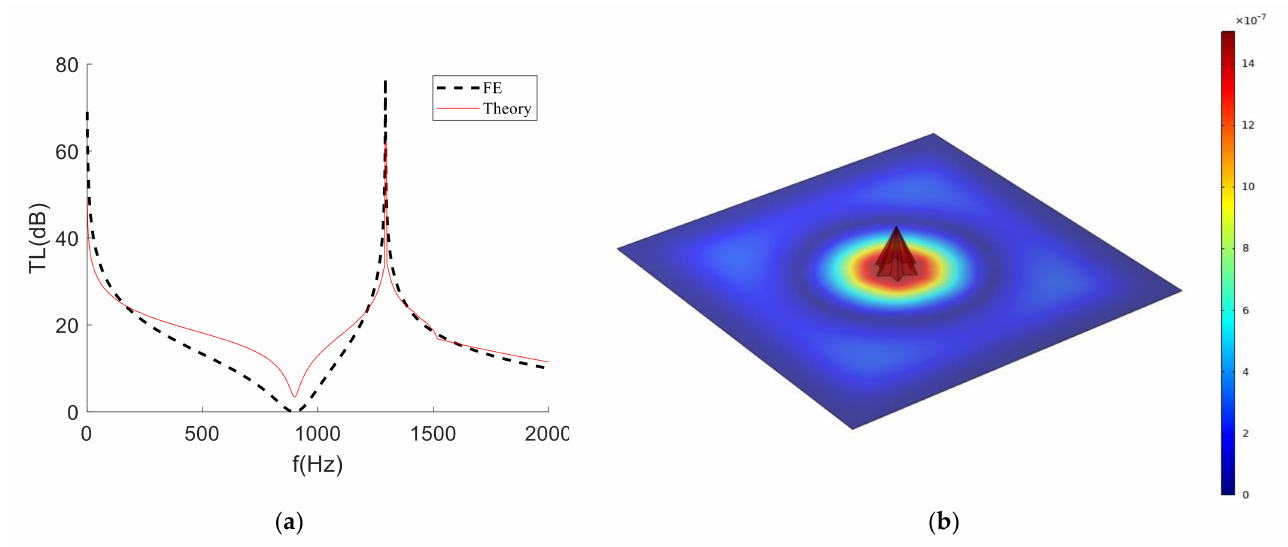
Figure 7. Comparison of simulation and analysis results of hexagonal cone membrane-type meta- materials. ( a ) Comparison of STL between semi-analytical method and finite element simulation. ( b ) Surface vibration velocity of this MAM at 1292